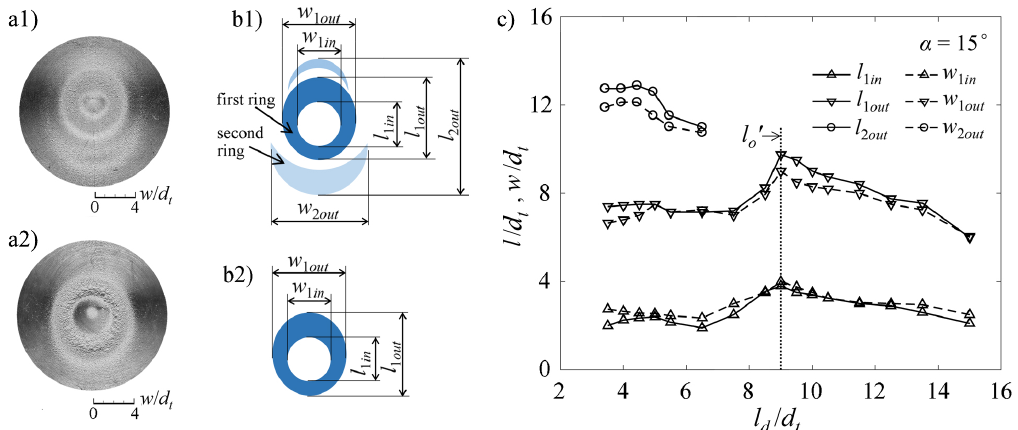
Figure 8. Normal view of eroded surface at α = 15 ◦ : ( a1 ) l d / d t = 5, ( a2 ) l d / d t = 9, ( b1 , b2 ) schematics of erosion area, ( c ) erosion distribution.